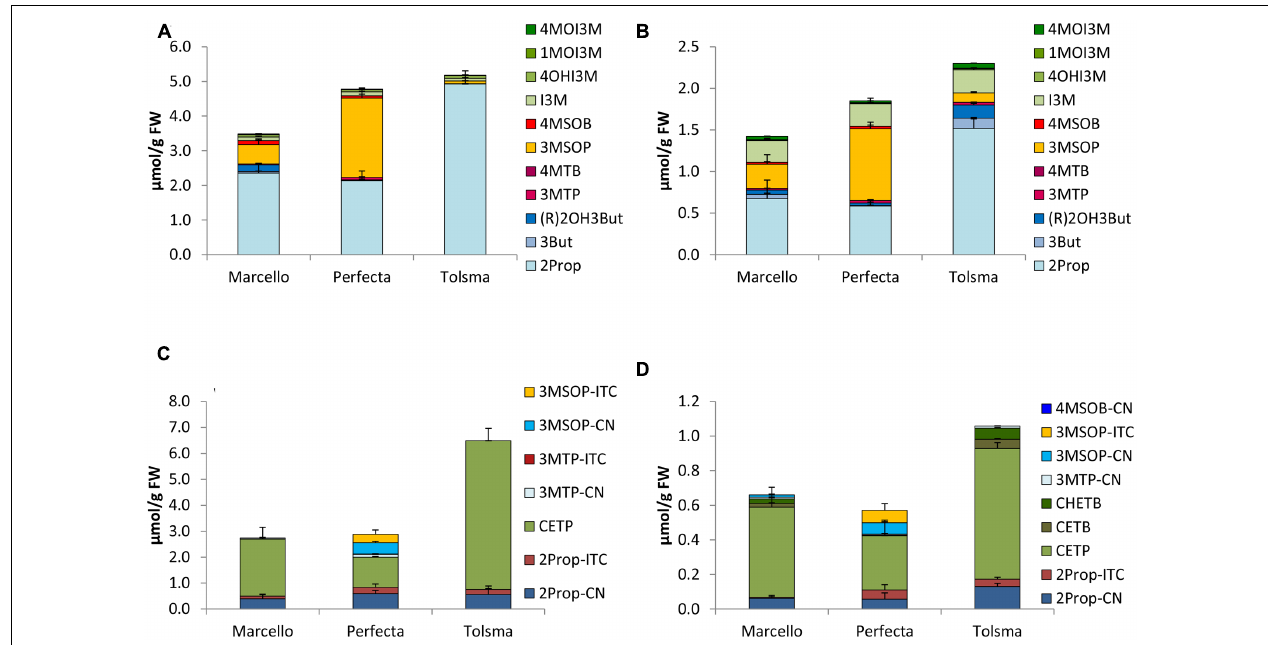
FIGURE 4 | Glucosinolates [ µ mol/g FW] and their hydrolysis products [ µ mol/g FW] in different cultivars of white cabbage in sprouts [ (A) GLSs, (C) hydrolysis products] and fully developed white cabbage heads [ (B) GLSs, (D) hydrolysis products]. Abbreviations: see Table 2 .